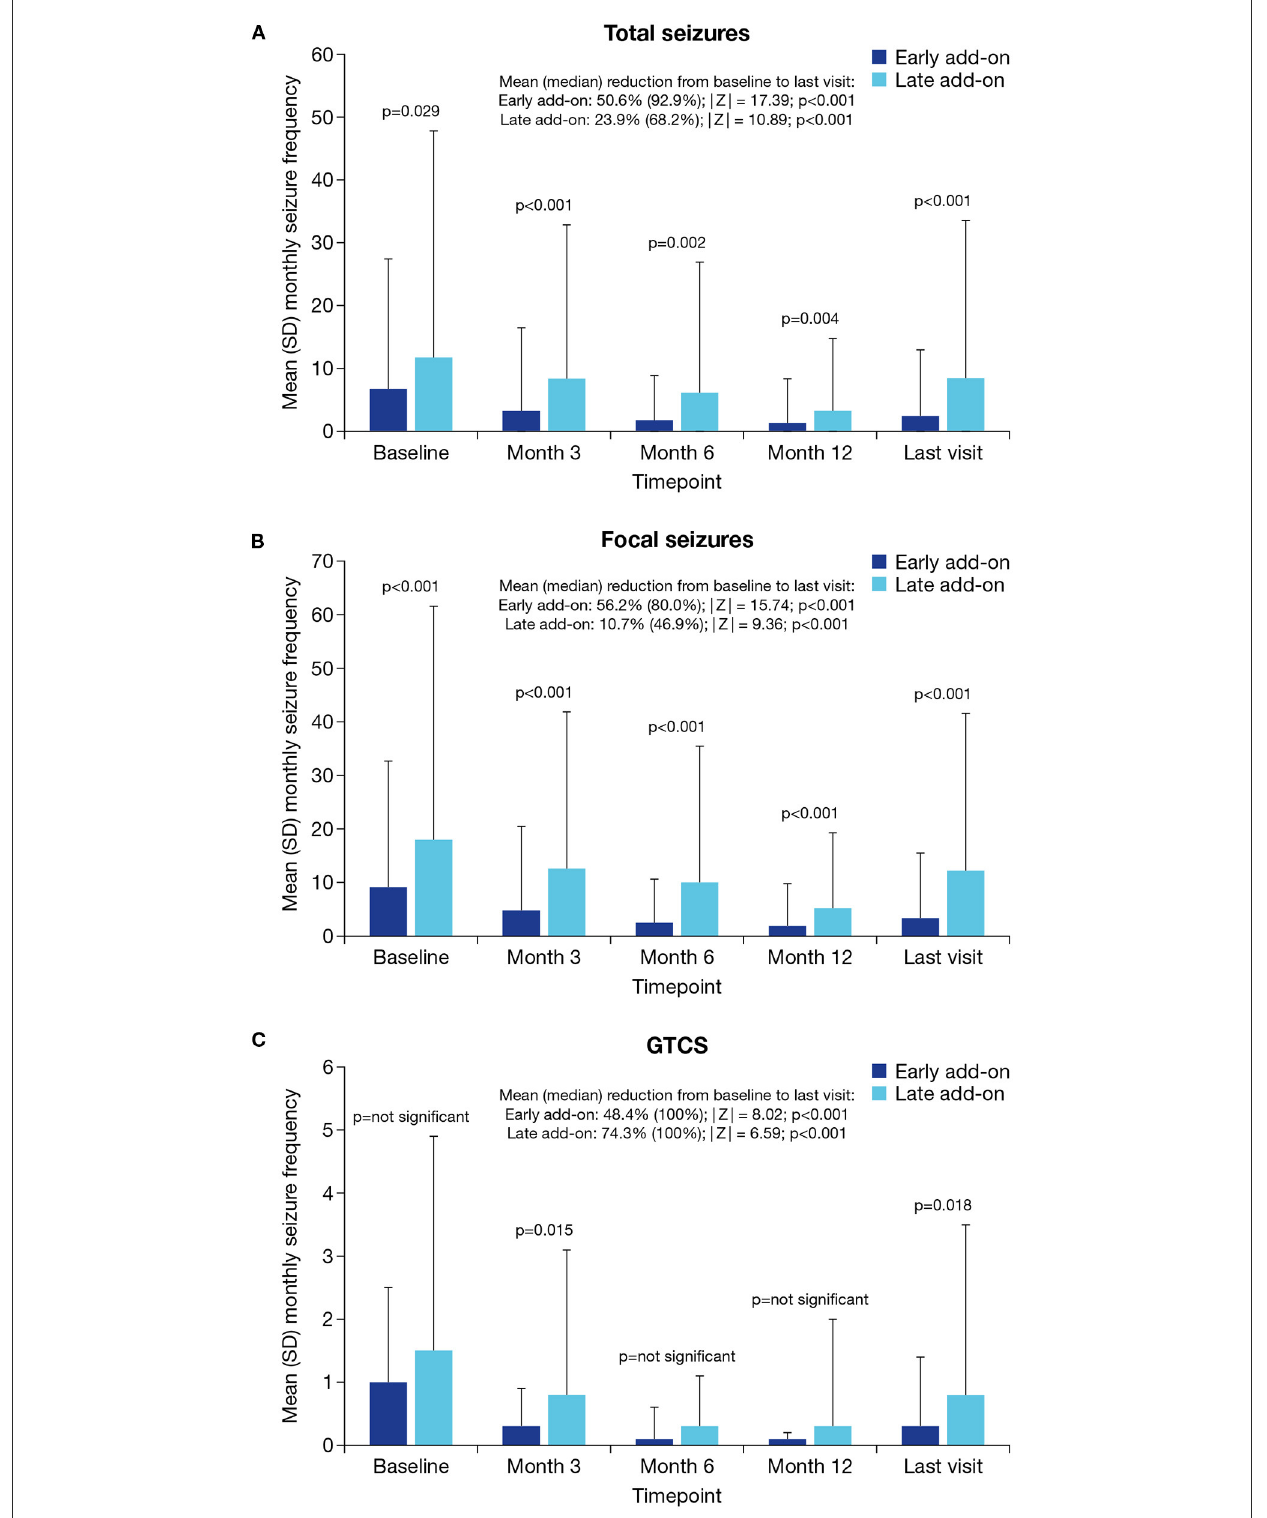
FIGURE2 Mean monthly seizure frequency at baseline, Month 3, Month 6, Month 12 and the last visit in the early and late add-on subgroups for (A) total seizures, (B) focal seizures and (C) GTCS (effectiveness population). GTCS, generalized tonic-clonic seizures; SD, standard